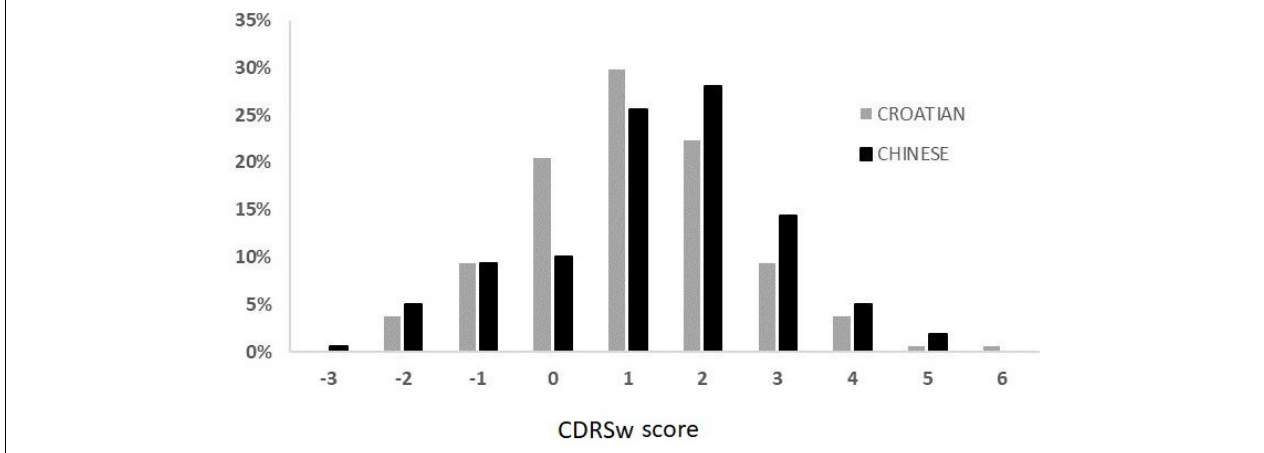
FIGURE 1 | Contour Rating Scale score percentages in both populations. A positive score indicates a preference for a slimmer body.